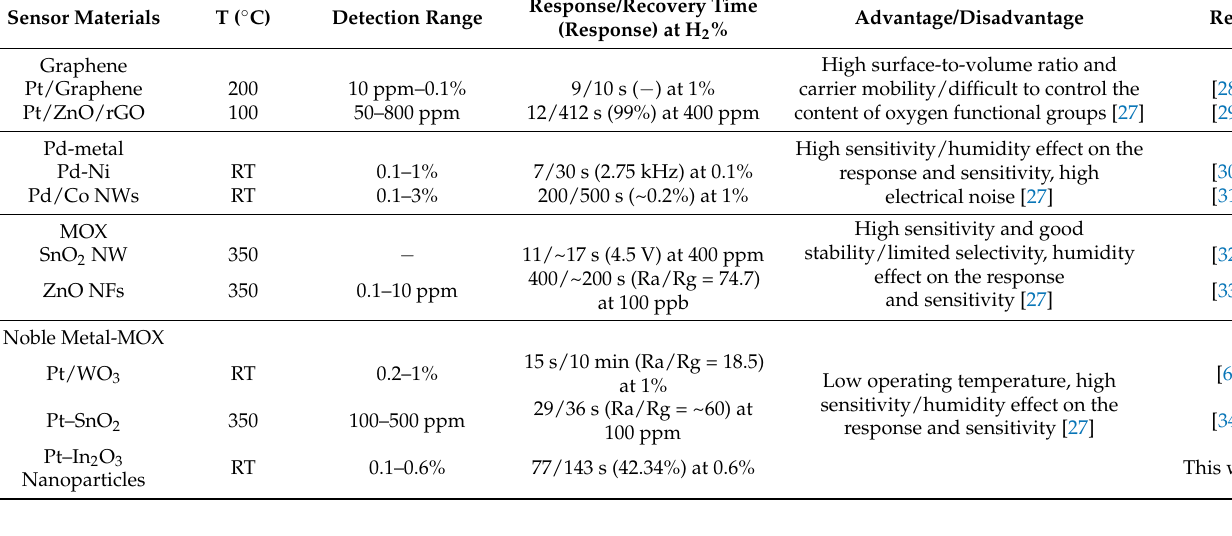
Table 1. Comparison of sensing performances towards hydrogen gas of sensors with various materials [6,26–34]. RT: room temperature, NW: nanowire, MOX: metal oxide, NF: nanofiber, R a : resistance in the air, R g : resistance in detection gas, –: not available. Adapted with permission from Ref. [27].